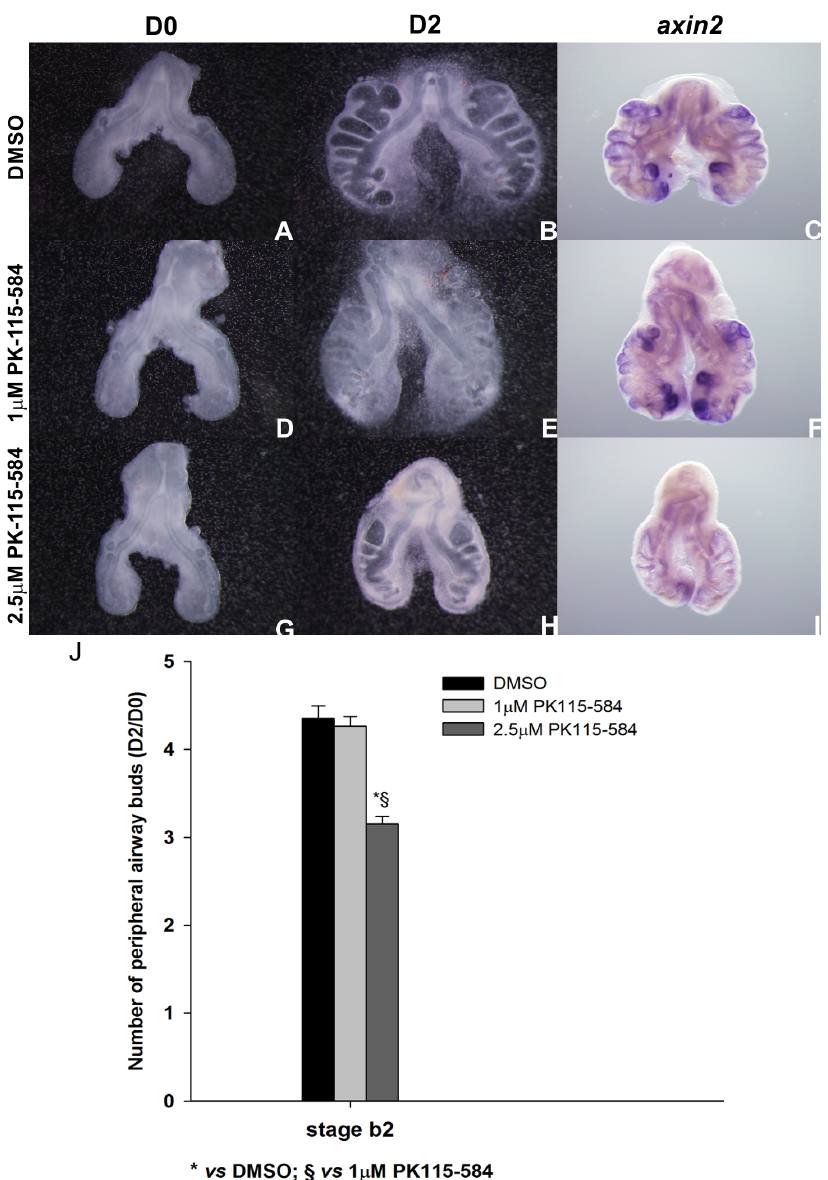
Figure 9. In vitro Wnt signaling inhibition (PK115-584) and branching analysis of lung explants. Representative examples of stage b2 lung explant culture, at D0:0h ( A, D, G, ) and D2:48h ( B, E, H ) treated with DMSO (A, B), 1 m M (D, E) and 2.5 m M (G, H) and probed with axin2 ( C, F, I ); n 5 4. Magnification: A, B, D, E, G, H –4x; C, F, I –5x. M : Branching analysis of stage b2 (n > 14 for each condition) explants treated with DMSO and PK115-584 (1 and 2.5 m M). Results are expressed as D2/D0 ratio. Data is represented as mean ¡ SEM. p , 0.001: * vs DMSO, 1 vs 1 m M of